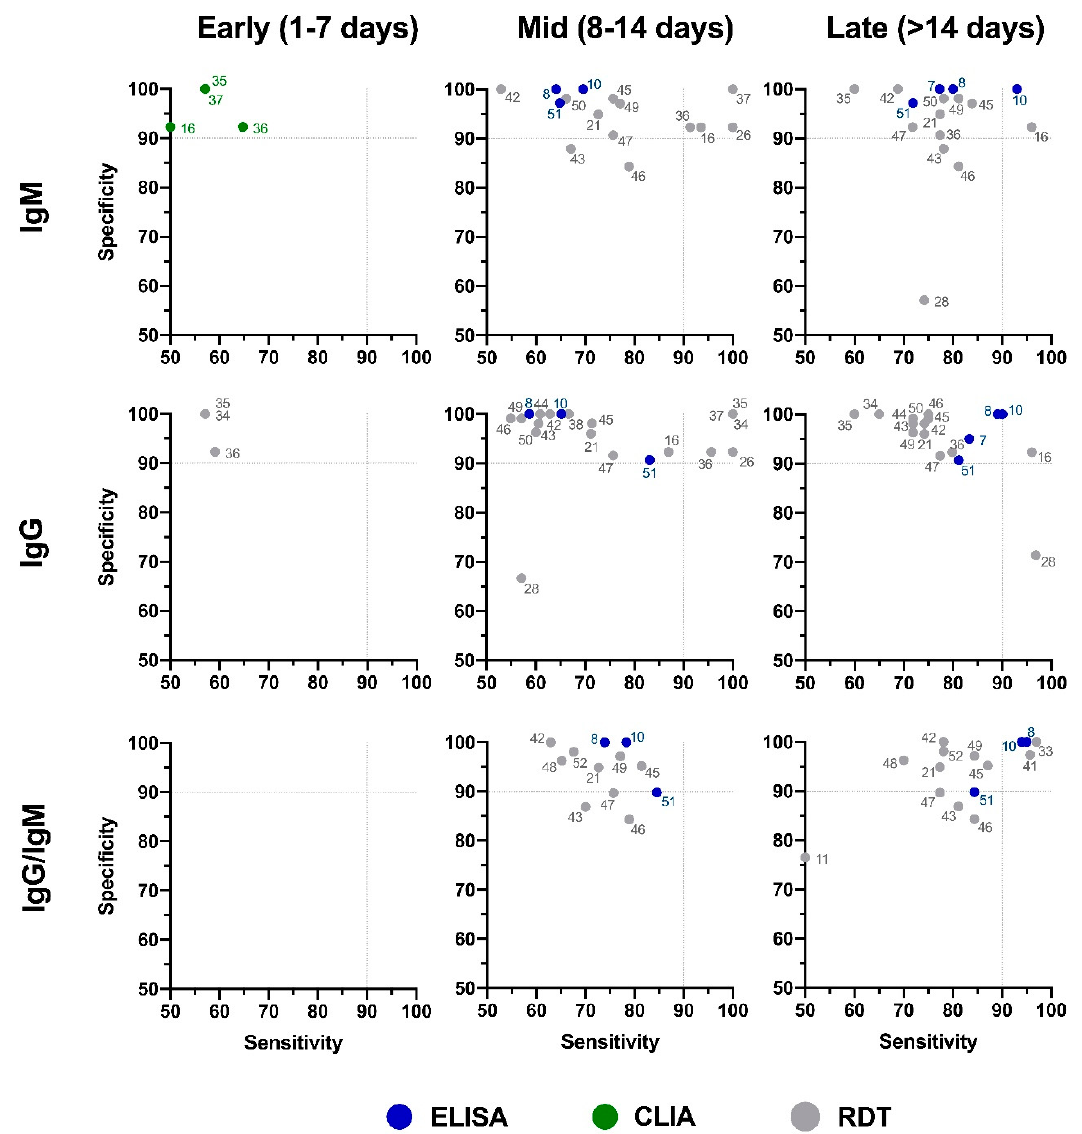
Figure 6. Independent evaluation of COVID-19 serological tests at various stages of the disease. XY plots of reported sensitivity and specificity in detection of IgM, IgG, or IgG / IgM antibodies were generated at different stages of the disease, including early (1–7 days after symptom onset), intermediate (7–14 days after symptom onset), and late (>14 days after symptom onset). ELISA: enzyme-linked immunosorbent assay; CLIA: chemiluminescence immunoassay; RDT: rapid diagnostic test (lateral flow immunoassay). Dotted lines represent 90% sensitivity and specificity levels. Refer to Figure 7 for test names and manufacturers associated with number shown here.